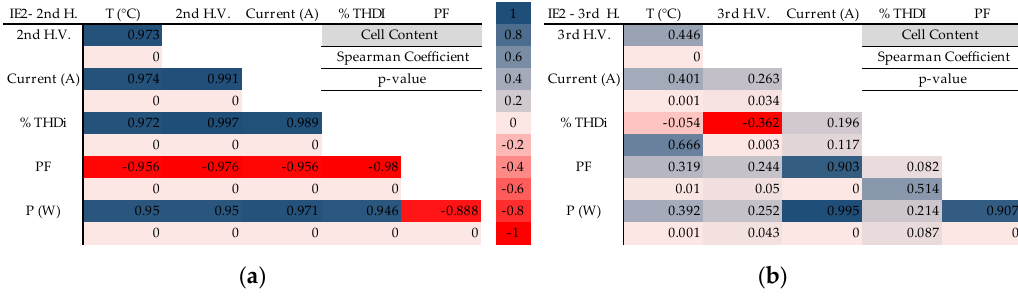
Figure 12. Correlation matrix between temperature and input parameters in IE2 class SCIM for ( a ) second harmonic voltage distortion; ( b ) third harmonic voltage distortion.